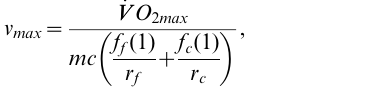
PLoS Computational Biology |